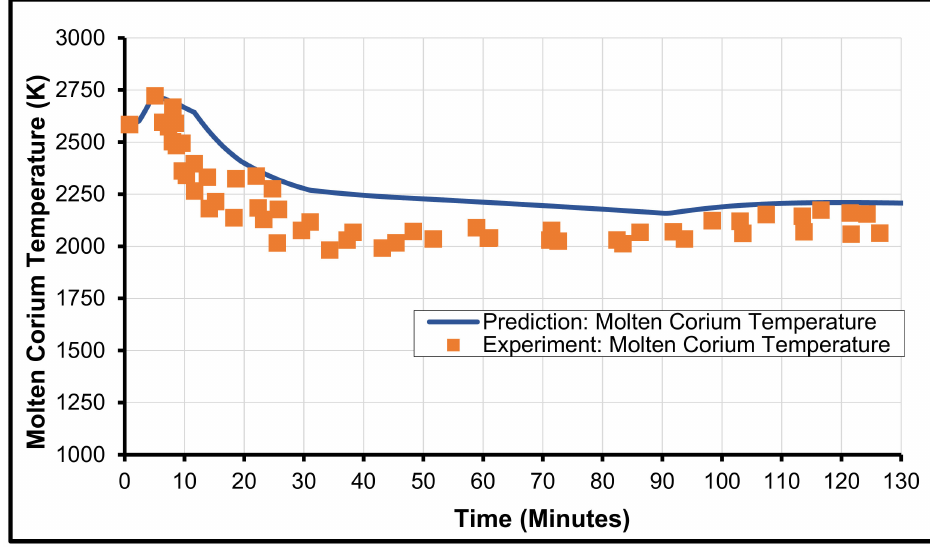
Figure 8. Comparison of SURC-2 experimental melt/corium temperature data (SURC-2) with the developed